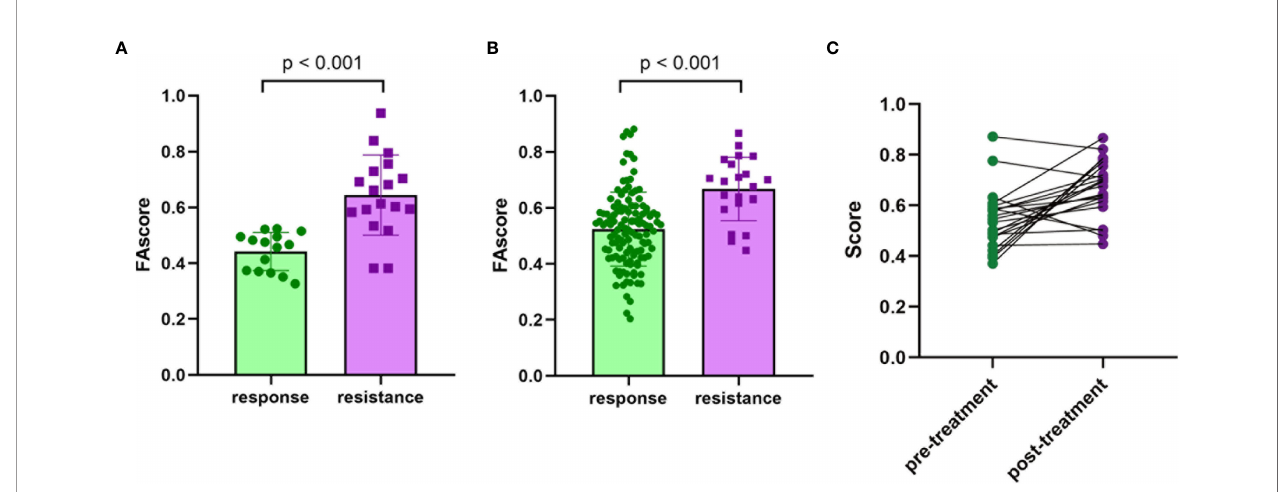
FIGURE 3 | Validation of the ef fi cacy predive value. (A) The values of the focal adhesion-related model score (FAscore) in patients with response and resistance to neoadjuvant chemotherapy in the training set. (B) The FAscores in the response and acquired resistance groups to cisplatin and fl uorouracil combination chemotherapy in the GSE14210 cohort. (C) The FAscores of samples before and after developing resistance to chemotherapy in the GSE14210 cohort.